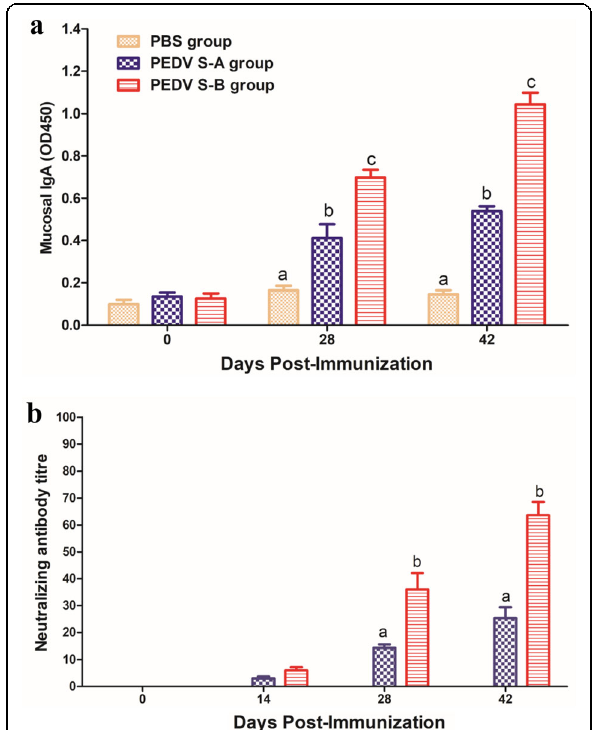
Fig. 3 Detection of PEDV-specific IgA in the small intestines of mice and PEDV-specific neutralizing antibodies. a Mucosal IgA detection. b Serum neutralizing antibody titers against PEDV. Data are represented as the mean ± SEM. Different letters ( a , b ) indicate a statistically significant difference between the different experimental groups ( P < 0.05). PEDV, porcine epidemic diarrhea virus